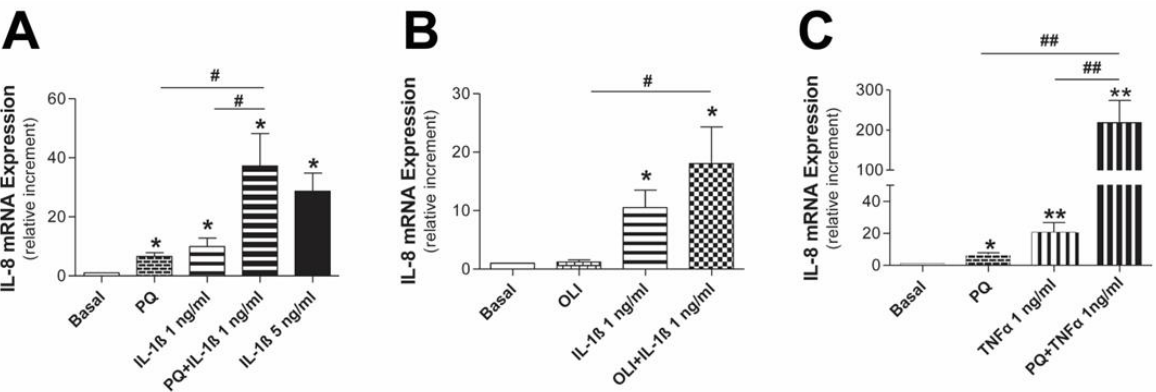
Figure 2. Mitochondrial dysfunction modulates IL-8 mRNA expression induced by cytokines in human mesothelial cells. Met5A cells were preincubated with the selective mitochondrial respiratory chain inhibitors paraquat (PQ; 1 mM) or oligomycin (OLI; 10 µg/mL) for 30 min before treatment with IL- 1β (1 ng /mL, 6 h) or TNFα (1 ng /mL, 18 h). IL-8 mRNA expression for ( A ) PQ + IL- 1β ( n = 5), ( B ) OLI + IL- 1β ( n = 7) and ( C ) PQ + T NFα ( n = 4) is expressed as the mean ± SEM fold change vs. basal condition. * p ≤ 0.05 and ** p ≤ 0.01 vs. basal, and # p ≤ 0.05 and ## p ≤ 0.01.